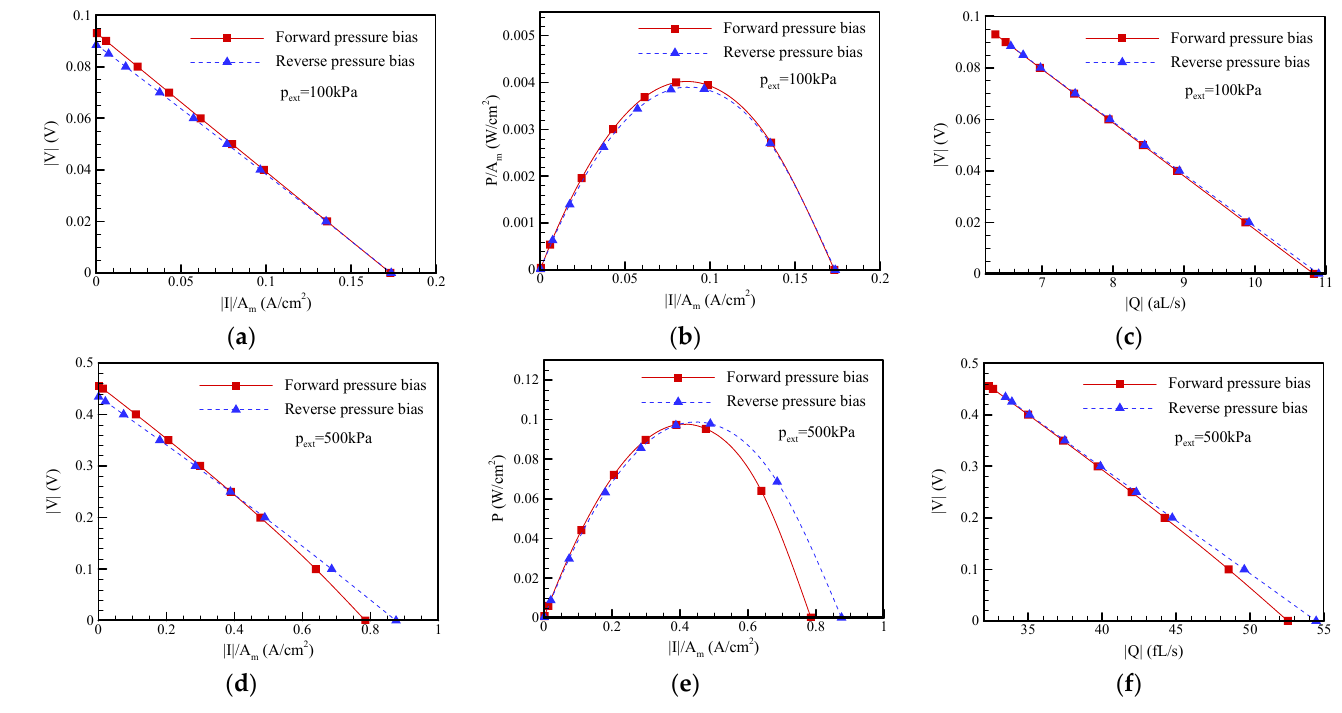
Figure 7. Plots of the I-V curve, I-P curve, and Q-V curve for EKEC in a conical nanopore at a salt concentration of c 0 = 1 mM under different pressure biases: ( a – c ) p ext = 100 kPa; ( d – f ) p ext = 500 kPa. Note that θ = 1.2 ◦ , σ s = − 5 mC/m 2 , and b = 20 nm. A m = π (a m ) 2 , where a m is the radius at the middle of the conical